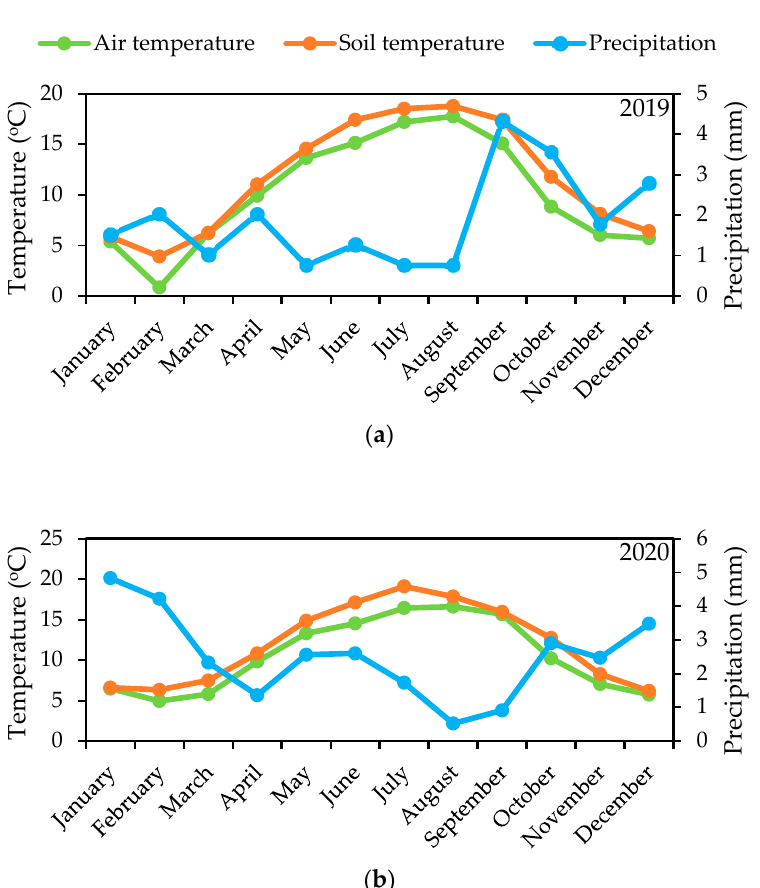
Figure 1. Average monthly air temperature, soil temperature, and precipitation of the experimental area in 2019 ( a ) and 2020 ( b ). Data provided by WSU AgWeatherNet.